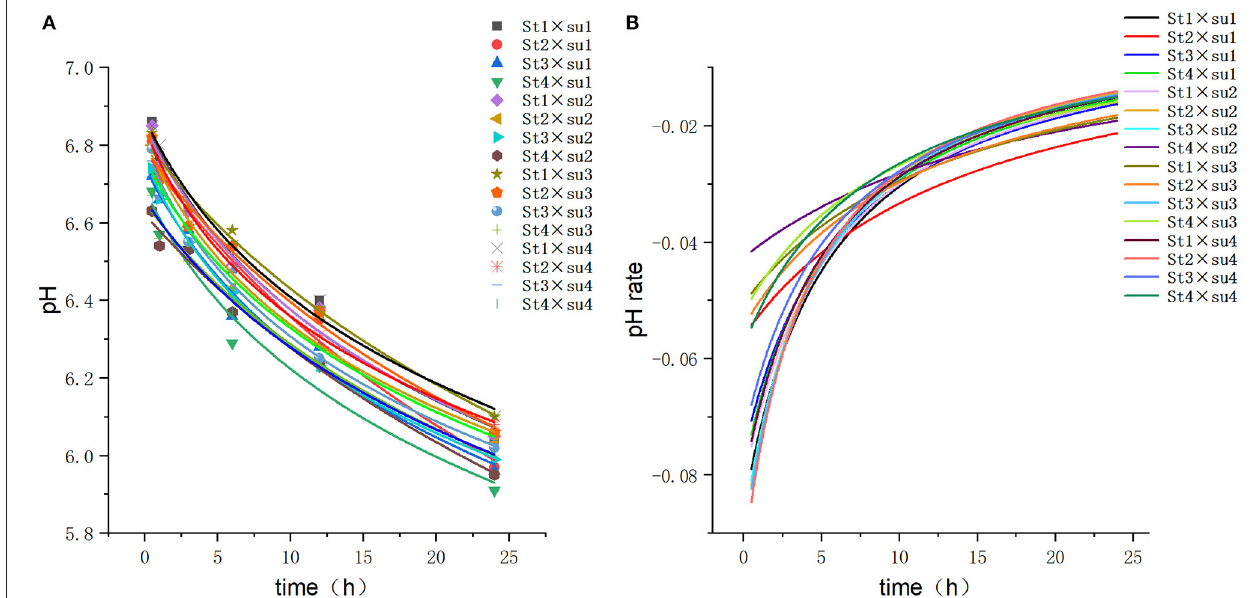
FIGURE 1 | Fitting model curve of pH. (A) Logarithmic model fitting curve. (B) Derivative of Logarithmic model.